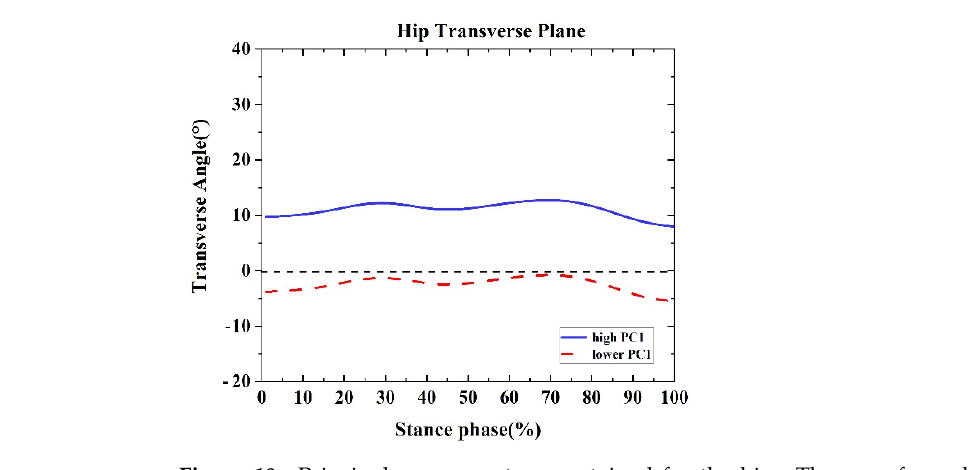
Figure 10. Principal components are retained for the hip. The waveform differences between competitive runners and recreational runners of reconstruction principal using the high and lower PC1-scores in the transverse plane.